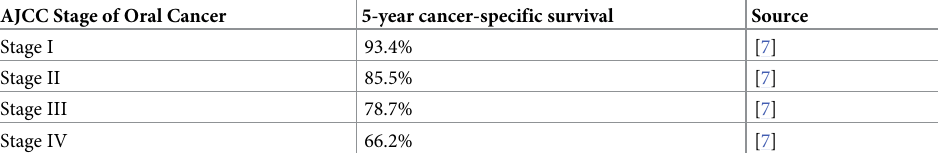
Table 2. 5-year cancer-specific survival rates for each AJCC stage of OSCC from the SEER database for patients with age at diagnosis 60–64 years, for included oral sites from 2004–2010.